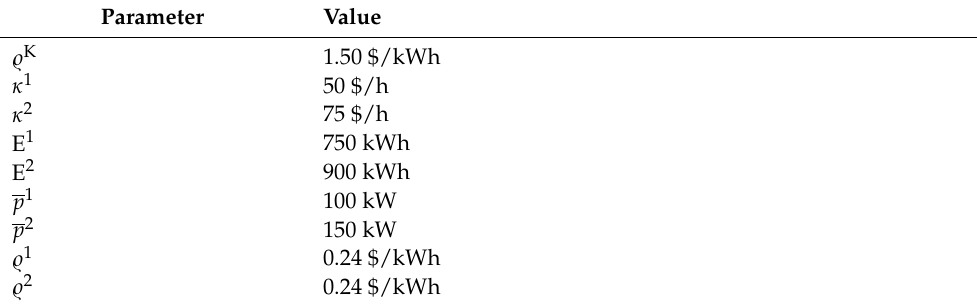
Table 7. Costs of DR programs.